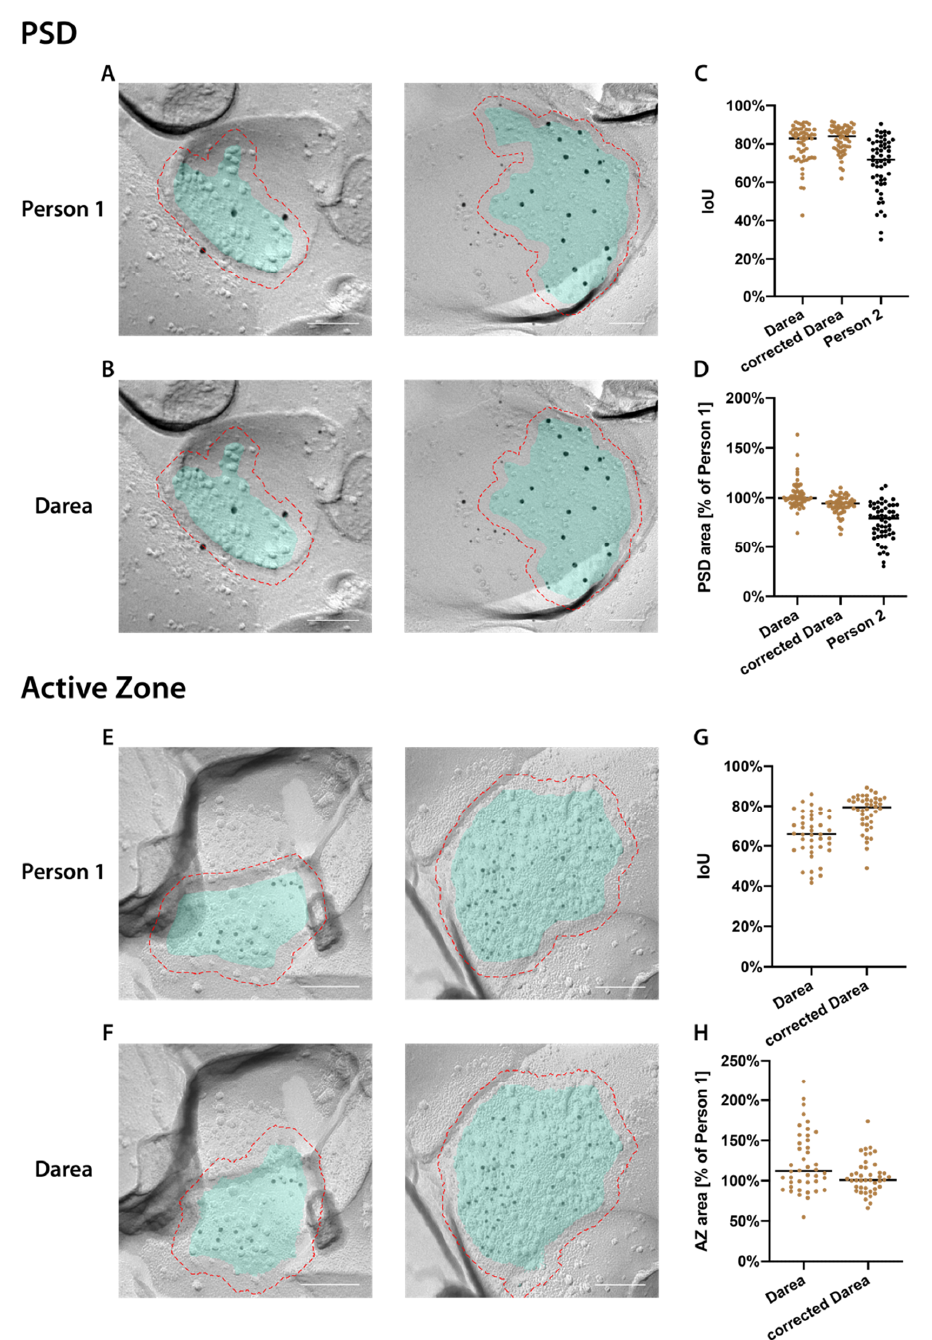
Figure 1. Automated demarcation by Darea. ( A,B ): Representative images of manual ( A ) and machine-demarcated ( B ) postsynaptic density (PSD) labeled for α-amino-3-hydroxy-5-methyl-4-isoxazolepropionic acid (AMPA) receptors (AMPAR) (6 nm gold particles) and GluN1 (12 nm gold particles) in the CA1 area. Cyan overlay indicates demarcated areas. Red dashed line indicates 30 nm rim around the demarcation. ( C,D ): Comparison of the accuracy of automated and human demarcation, calculated as the intersect over union (IoU) between the two demarcations ( C ) or percentage of demarcated PSD area ( D ) by Darea, Darea followed by human correction (corrected Darea) or manual demarcation by Person 2 with respect to manual demarcation by Person 1.